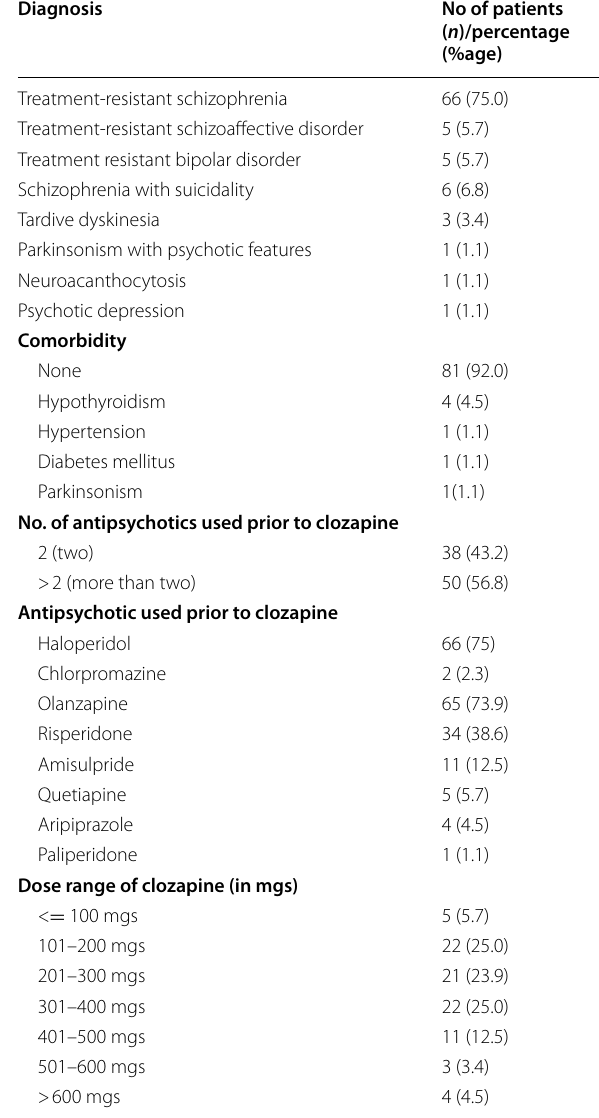
Table 1 Sociodemographic profile of patients on clozapine Demographic variables Number of patients